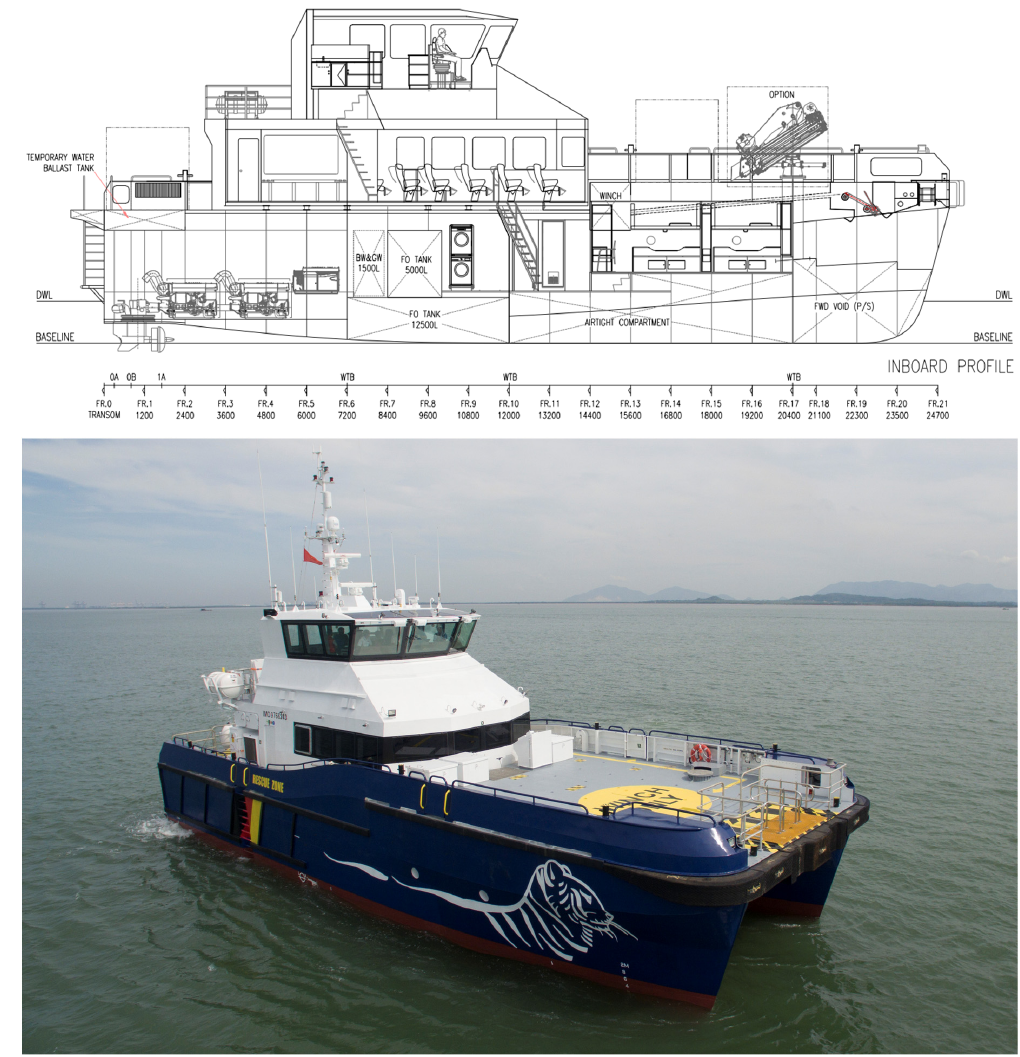
Figure 5. Crew Transfer Vessel – MHO Grimsby [44] IMO 9766243, (earlier OOC Nerz [46]).